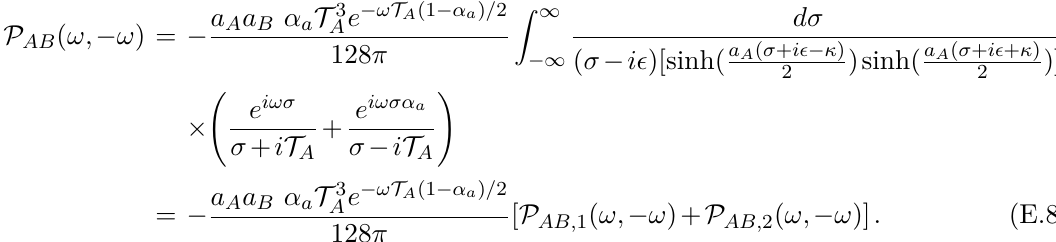
Figure 12. Plots showing contours of integral (a) P AB ( ω, − ω ) , (b) P AB ( − ω, ω ) , where contributing poles are in upper and lower half of the complex- σ plane , respectively. The poles M defined as κ − i(cid:15) + i 2 πn and − κ − i(cid:15) + i 2 πn , a A a A